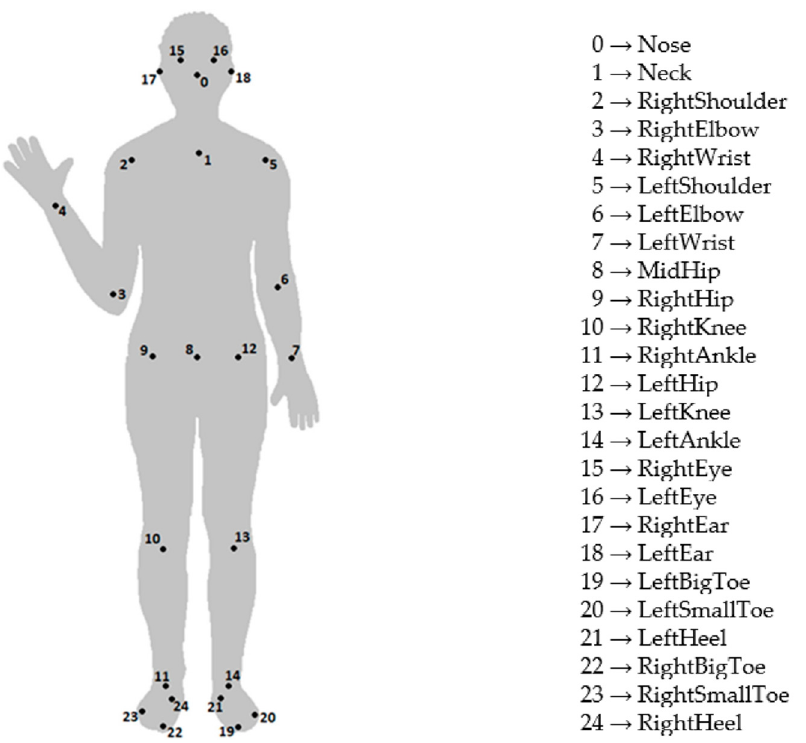
Figure 2. The KeyPoints of the BODY-25 model.